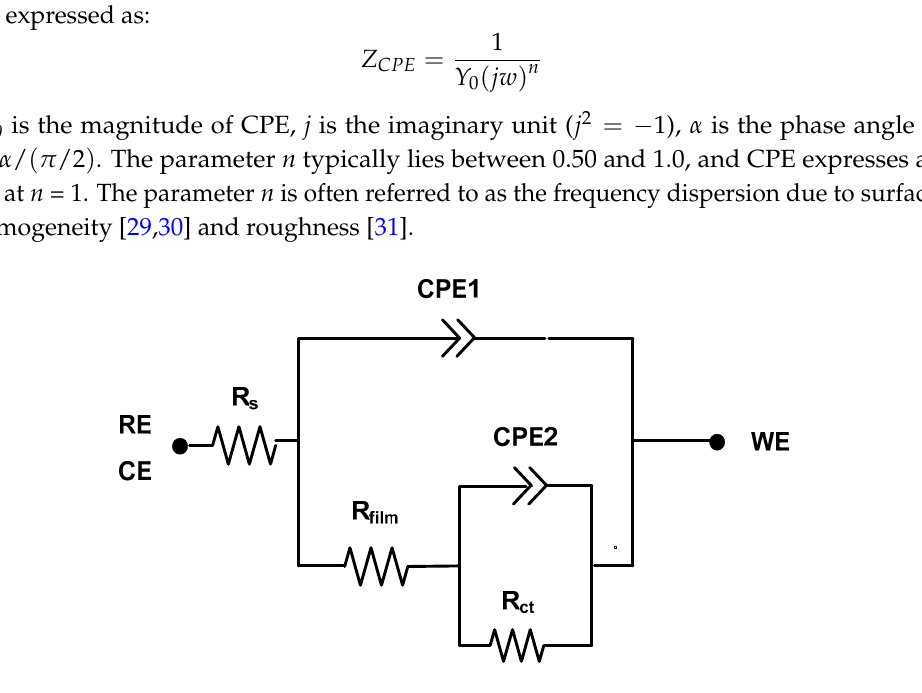
Figure 5. Equivalent circuit to fit the electrochemical impedance spectroscopy (EIS) data.